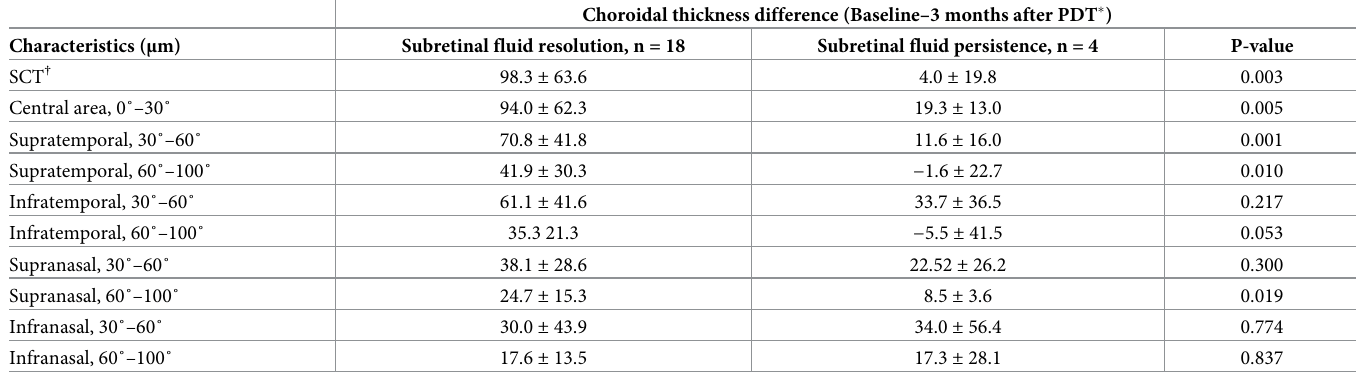
Table 4. Changes in choroidal thickness before and after photodynamic therapy in patients with central serous chorioretinopathy by region and treatment outcome.